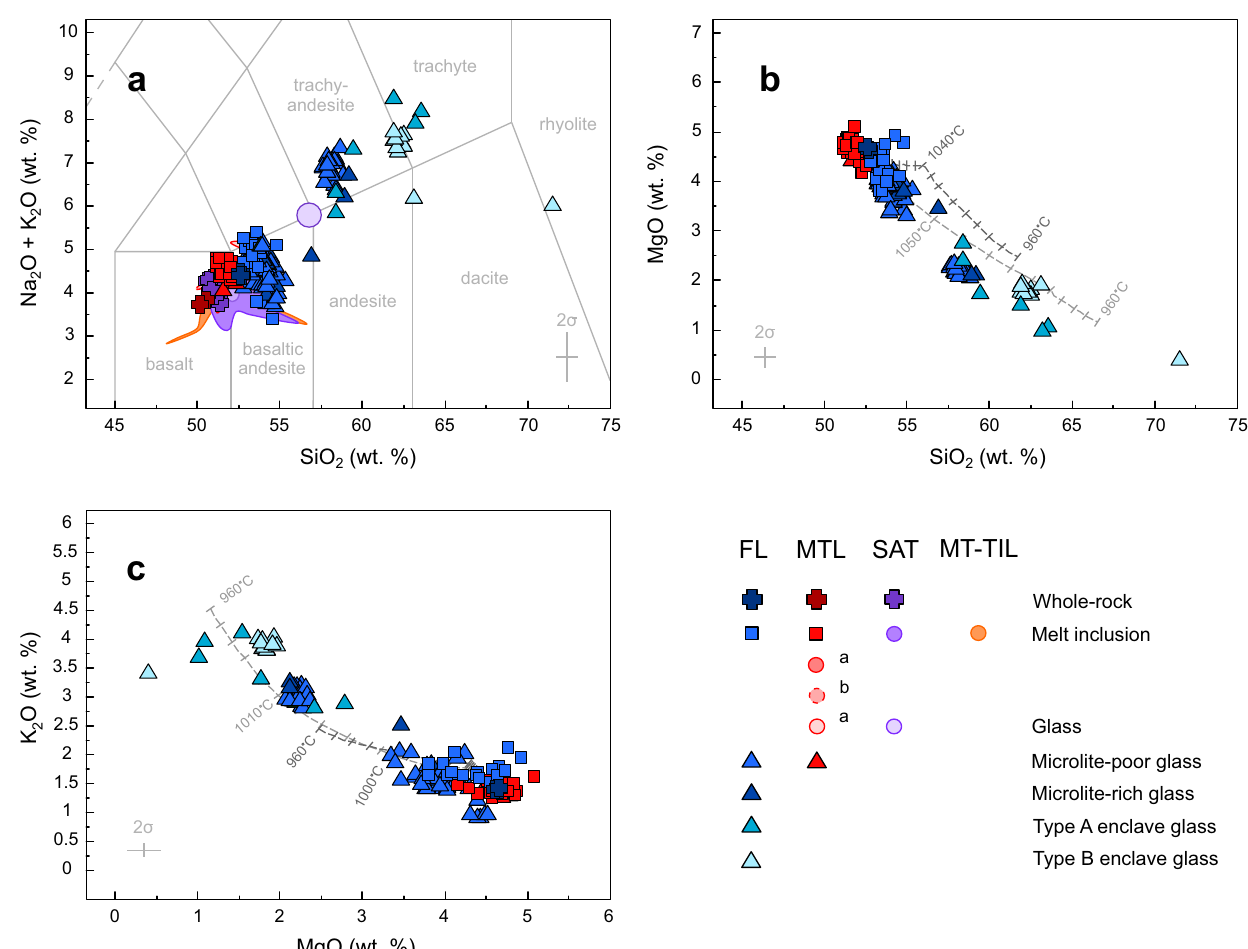
Fig. 3 Harker style diagrams illustrating the geochemical evolution of eruption products from Las Sierras-Masaya volcanic system. (a) A TAS plot illustrating the geochemical evolution of products sampled from a series of eruptions at Las Sierras-Masaya volcanic system. Accompanying the results from this study on the FL and MTL eruptions are additional whole-rock, MI and glass compositions of the MTL 16,23 , SAT 13 and MT-TIL 23 eruptions. For the MTL eruption, data from 16 is indicated by a and data from 23 by b in the legend. ( b ) MgO vs SiO 2 and ( c ) MgO vs K 2 O for whole-rock, MI, glass and enclave glass compositions in samples of the FL eruption. MI (red squares) and glass (red triangles) compositions of MTL samples from this study are also presented. MI from this study are PEC-corrected compositions. The liquid line of descent calculated by Rhyolite-MELTS 33 simulations is indicated by the grey dashed line, with tick marks representing an incremental temperature step of 10 °C, from 1080 to 960 °C, at a fi xed pressure of 40 MPa and fO 2 of NNO-0.65. The dark-grey dashed line represents a liquid line of descent performed at a higher fi xed pressure of 200 MPa, for the same temperature range and fO 2 . Error bars represent the analytical uncertainty (2 σ